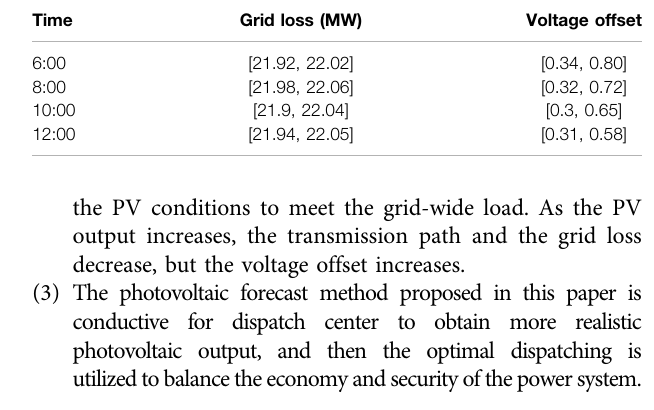
TABLE 5 | Comparison of optimal power fl ow